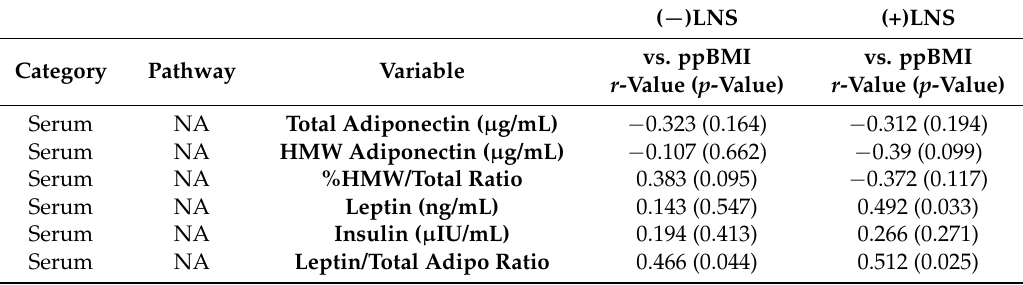
Figure 1. Branched chained amino acids levels ( A ) leucine + isoleucine and ( B ) valine. Data are expressed as mean ± SEM. Statistical differences for branched chain amino acid levels were determined using two-way ANOVA to examine differences due to maternal lipid-based micronutrient supplementation (LNS) and pre-pregnancy BMI category. Tukey’s post hoc testing was performed for multiple comparisons. Statistical significance was set at p ≤ 0.05. Different letter superscripts denote significance. Table 2. Regression analysis of serum parameters in relation to maternal pre-pregnancy body mass index (ppBMI) at 12 weeks gestation was performed using Pearson correlations. “ r -value ( p -value)” are listed, and color coded (green = positive) for direction of correlation if the p -value ≤ 0.05.